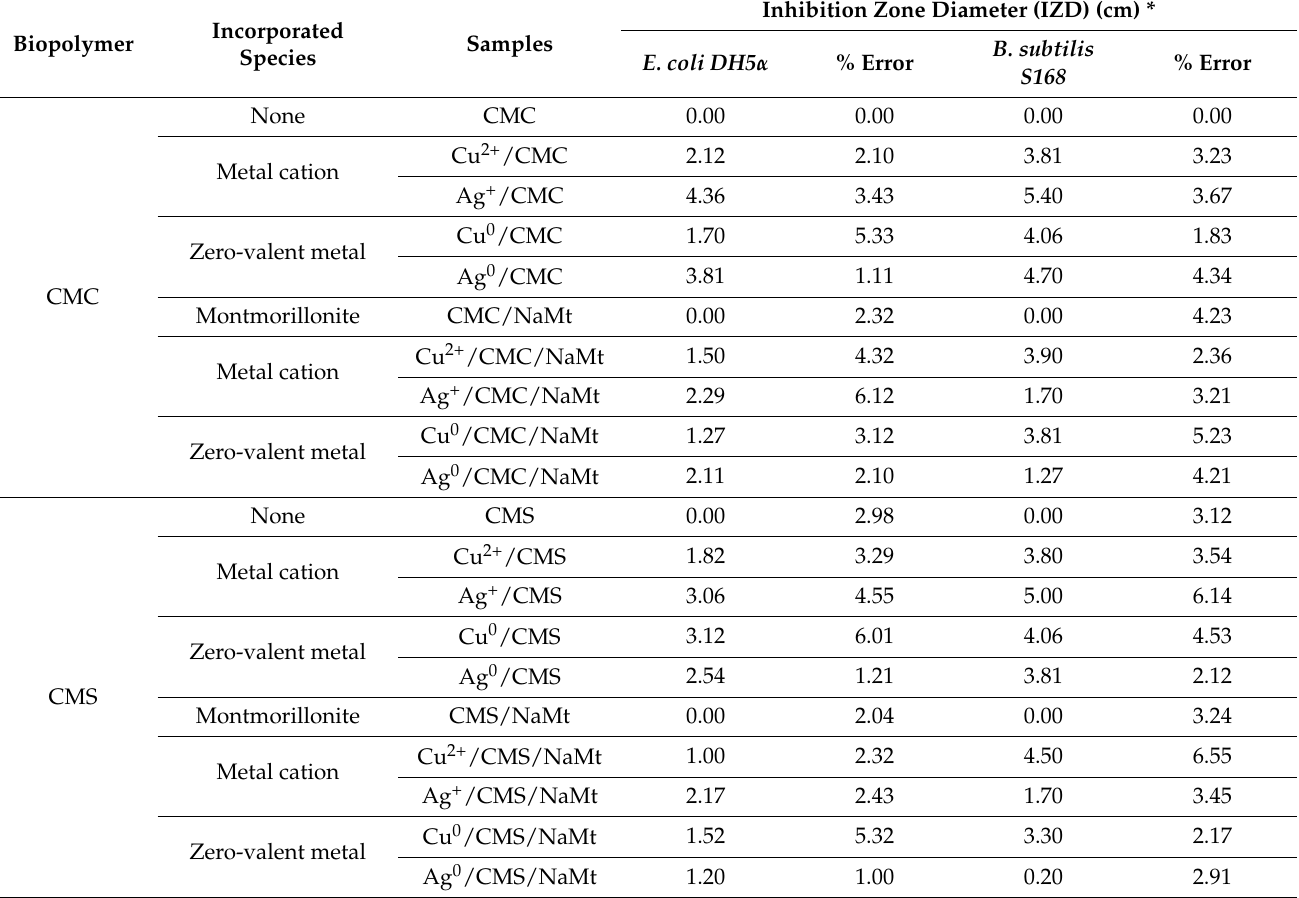
Table 3. Inhibition zone diameter (IZD) for CMC- and CMS-based